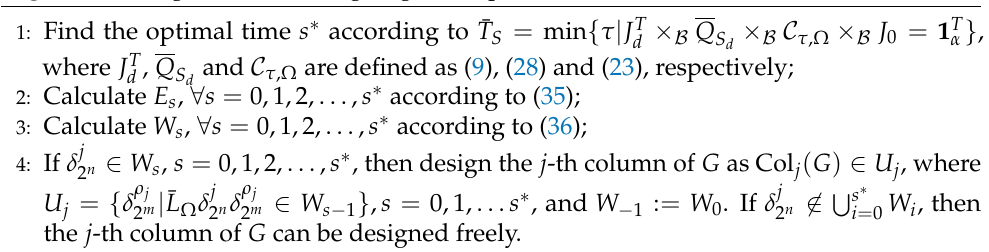
Algorithm 1 Algorithm for designing time optimal set